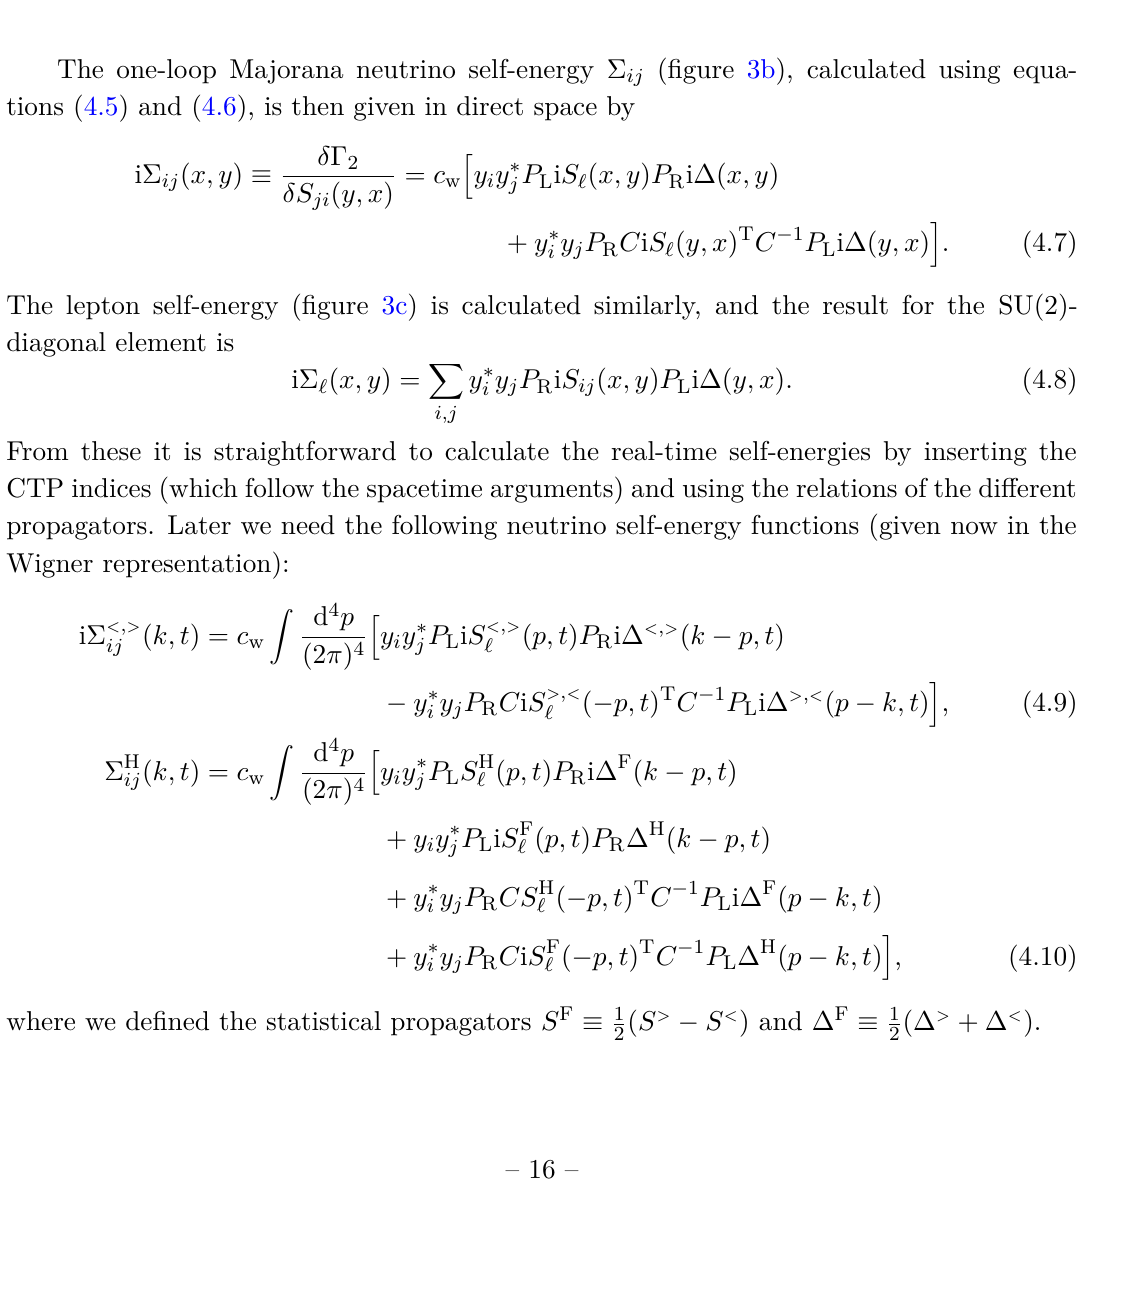
Figure 3. Shown on the left (a) is the 2PI two-loop vacuum diagram in theory (4.1). The corresponding 1PI diagrams contributing to the Majorana neutrino (b) and lepton (c) self-energies are shown on the